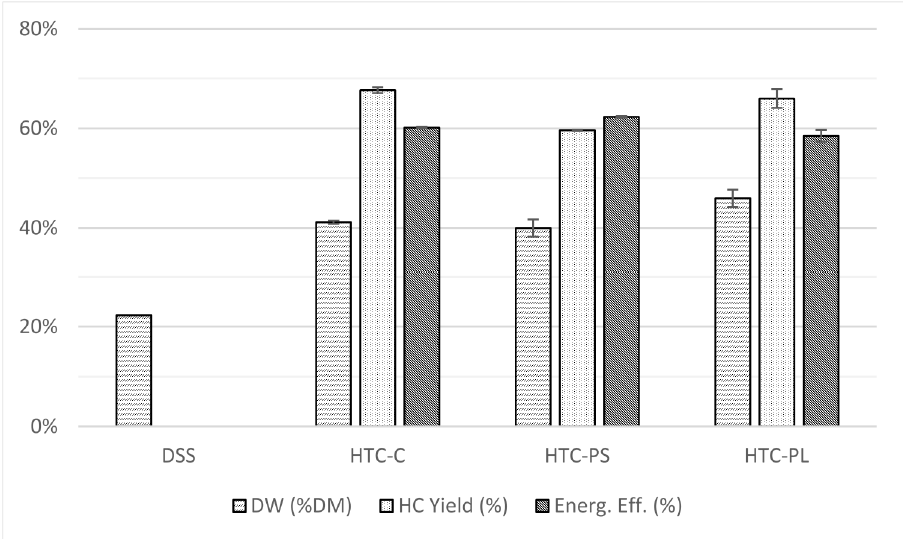
Figure 4. Dewaterability (DW), hydrochar (HC) yield and energy efficiency of the raw material (DSS as received), the control and acid treated hydrochars (Error bars show standard deviation of n = 2).